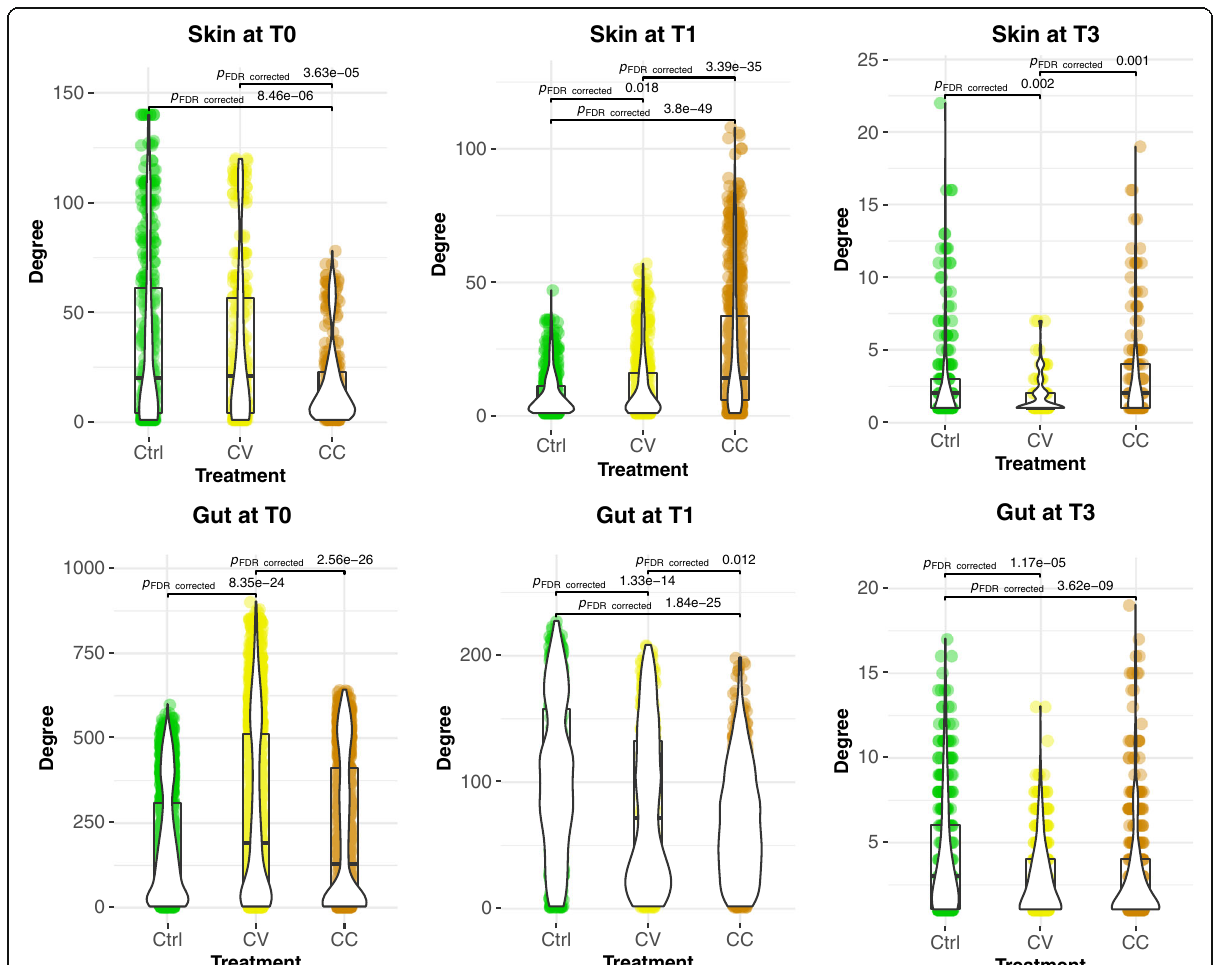
Fig. 3 The average degree of host-microbiome networks over time and between treatments. The connectivity represented with violin plots are significantly higher in average for the control groups in the gut and the skin at time T3, whilst at T1, they were significantly higher for cadmium-treated groups only in the skin. The average of nodes ’ degree computed with Network Analyzer was compared using the Kruskal-Wallis test followed by Benjamini-Hochberg test. The value of 0.05 is the threshold of B-H p -value significance. Only the significant Dunn test p -values for pairwise comparisons are displayed on this figure, however in order to improve visibility, the significant p -values of Kruskal-wallis test for multiple groups comparisons were not